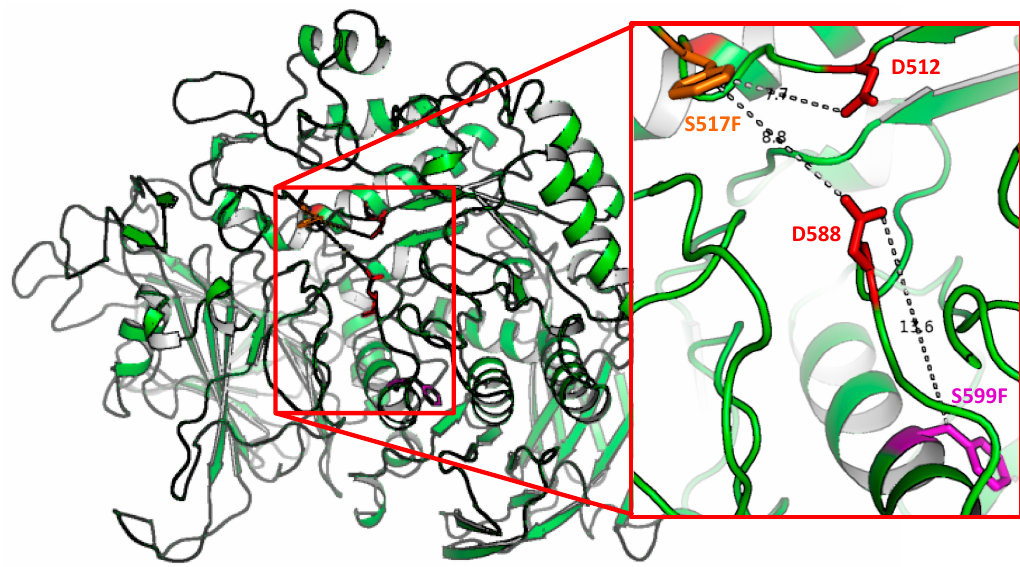
Figure 4. Structural mapping of the psl5-1 and rsw3 missense mutations in At ER α -glucosidase II. Homology model of the At ER α -glucosidase II α subunit in green cartoon representation. The inset shows the At psl5-1 mutant S517F point substitution (orange sticks), and the At rsw3 mutant S599F substitution (magenta sticks). The catalytic Asp residue D512 and the acid–base catalyst residue D588 are depicted in red sticks. The distances between the mutated residues and the catalytic residues are indicated by dotted lines, with the distances in Å. Both the S517F and the S599F mutations are likely to destabilise the catalytic domain of the enzyme.